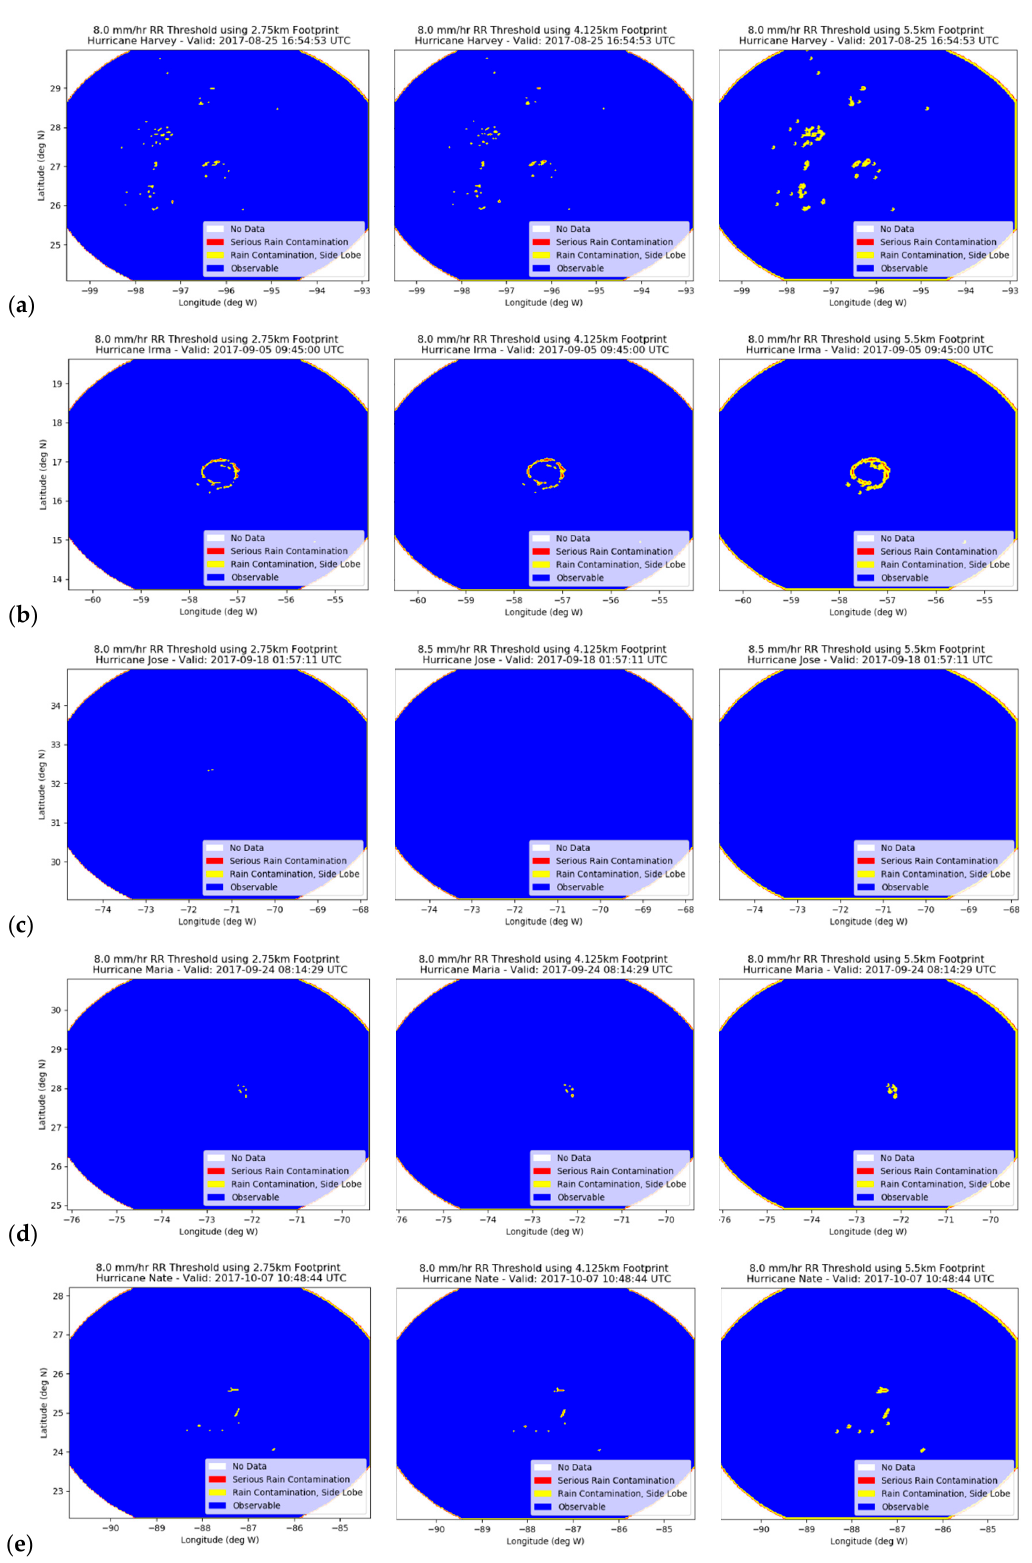
Figure 7. 8.0 mm/hr rain rate threshold applied to data for ( a ) Harvey-AL092017, ( b ) Irma-AL112017, ( c ) Jose-AL122017, ( d ) Maria-AL152017, and ( e ) Nate-AL162017. Rain rates at or below the threshold and surface observable ( blue ), rain rate at or below the threshold but surface not observable due to problems somewhere in the footprint ( yellow ), and rain rate exceeds the threshold ( red ).